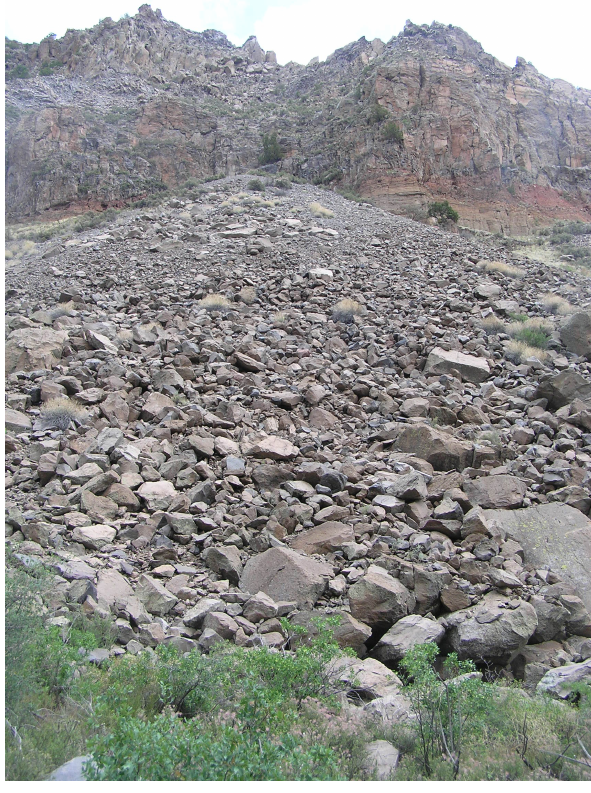
Figure 1. Image of talus slope at the base of cliffs of the Bandelier Tuff showing downslope sorting of particle sizes, with the largest particles preferentially accumulating near the base of the slope. The largest boulders in the foreground are about 1m in diameter. As de- scribed in the text, we suspect that with conversion of translational to rotational kinetic energy, large spinning particles are less likely to be stopped by collisional friction than are small or angular parti- cles for the same surface roughness, thus contributing to the sorting in this image. Image location is at the confluence of the Rito de los Frijoles river canyon with the Rio Grande river canyon on the east- ern boundary of the Bandelier National Monument, New Mexico,